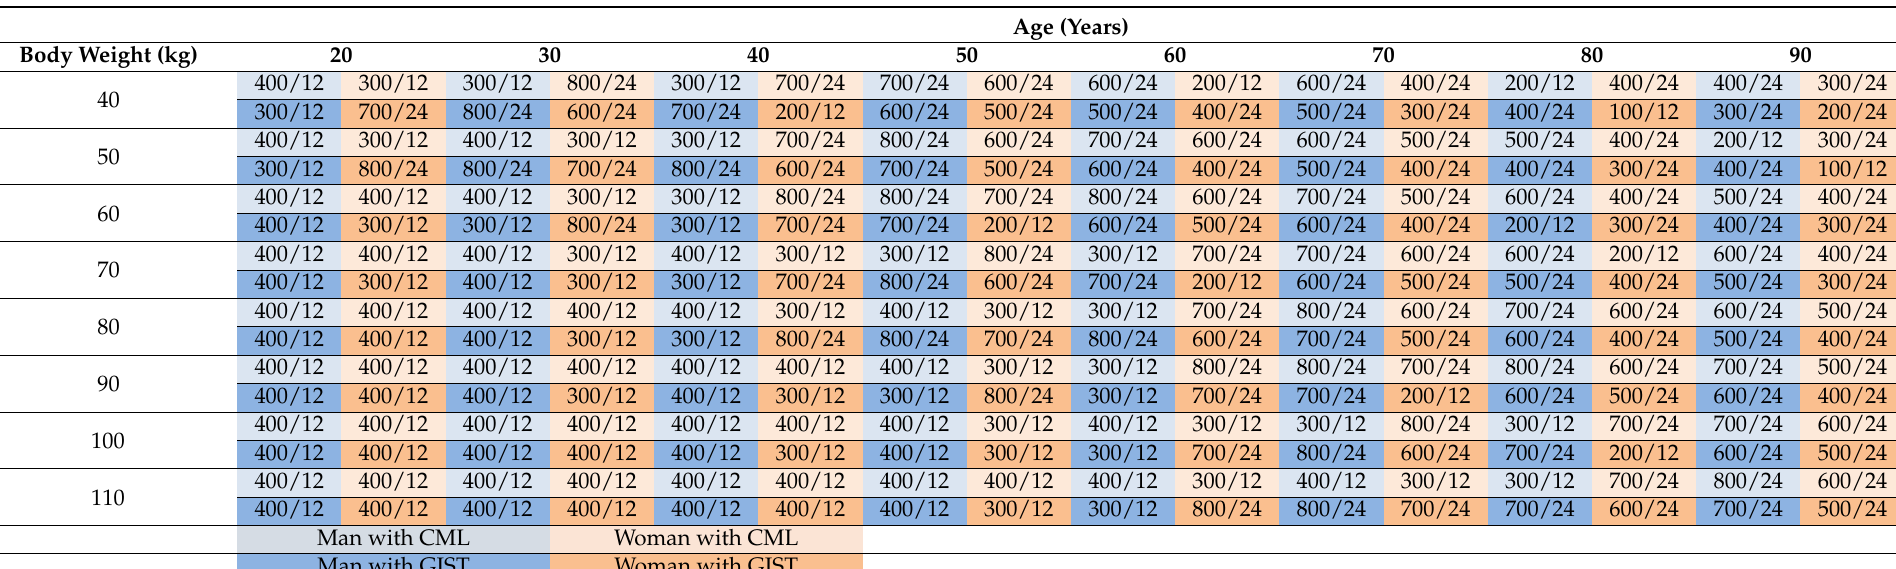
Table 5. Imatinib dosage recommendations based on the TID approach according to age, body weight, sex and disease. The suggested dosage regimens (dose in mg/dosing interval in hours) are those calculated with the TID-ODint approach to maximize the probability to achieve a Cmin target interval of 1000–2000 ng/mL at the steady-state. The color code is as